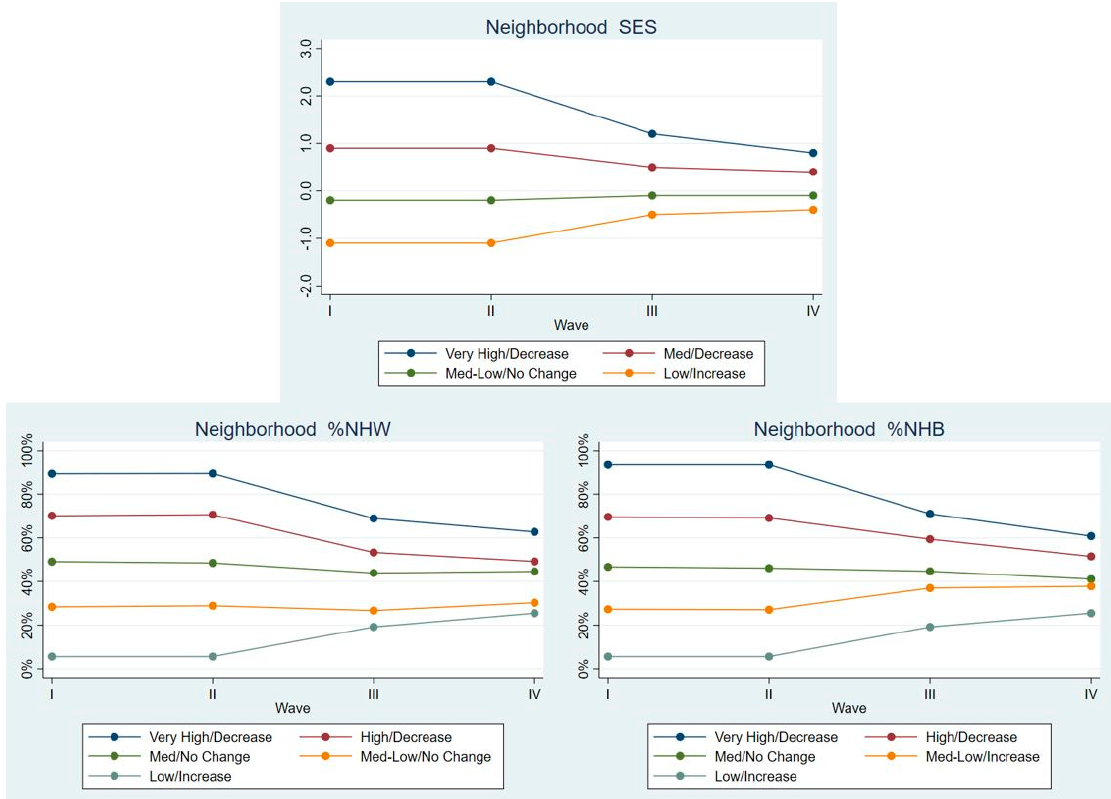
Figure 2. Latent class means for each neighborhood characteristic by Wave, non-Hispanic Blacks.